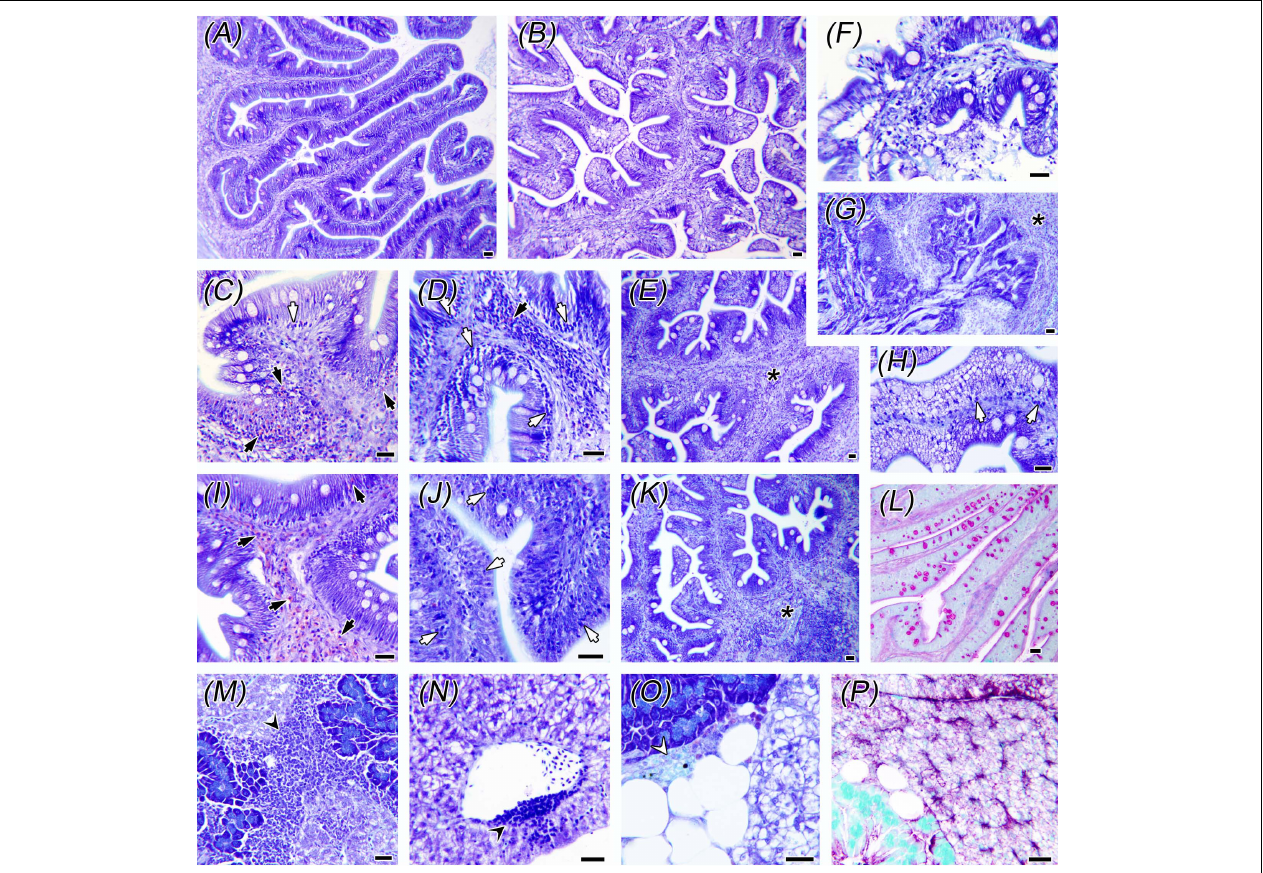
FIGURE 1 | Histological alterations in intestine and liver. Control fish anterior (AI) and posterior (PI) intestines are shown in panels (A,B) , respectively. Panels (C–H,L) correspond to PI of fish fed the 50LSAqua diet, (I-K) correspond to AI of the 100LSAqua diet, and (M–P) to livers of the 50LSAqua diet. Note the inflammatory reaction in both intestinal segments consisting of eosinophilic granular cells (EGCs) (black arrows), intraepithelial lymphocytes (IELs) (white arrows), and submucosal hyperplasia (asterisks). Epithelial necrosis and desquamation (F–G) , together with lipid vacuolization in enterocytes (H) and higher abundance of PAS + Goblet cells (L) were found in 100LSAqua-PI. Livers presented lymphocyte aggregates (black arrowheads) close to pancreatic acini (M) and blood vessels (N) , early melanomacrophage centers (white arrowhead) and large lipid depots (O) , and moderate glycogen storage (P) . All images are Giemsa-stained sections, except (L) and (P) PAS-stained. Scale bars = 20 µ m.